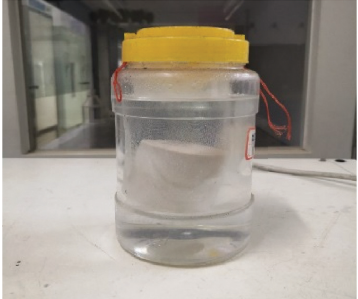
Figure 4: Leaching test of TBP/OK.